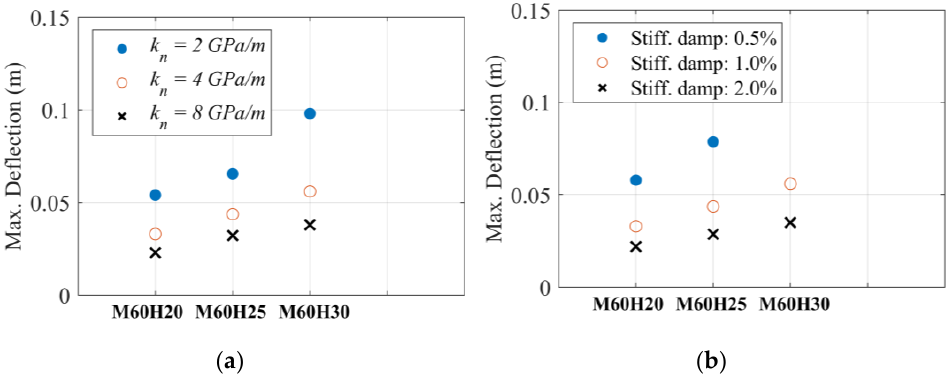
Figure 14. Effect of ( a ) stiffness and ( b ) damping ratio on the maximum deflections of stone masonry arch subjected to impact